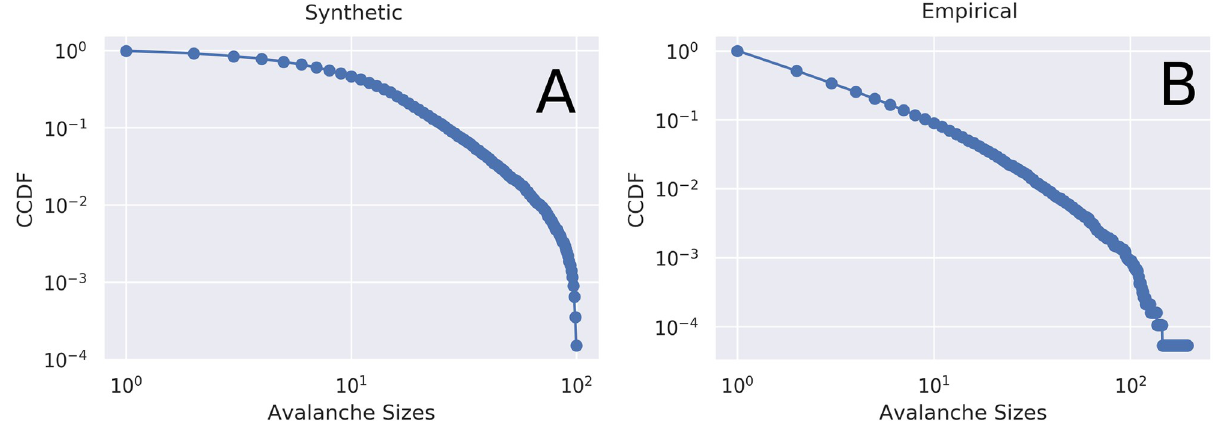
Fig 5. Synthetic and empirical doubly-truncated power law distributions for the data. A : an empirical, doubly-truncated power-law distribution taken from this dataset with an x min of 16 and an x max of 196. Within this range, the exponent has been estimated to be 2.7. B : a synthetic doubly- truncated power-law distribution with the same minimum and maximum values as the empirical distribution as well as the same exponent. Note that the synthetic model has significant curves which begin well before the upper-bound cut-off. When modelling a system that produces data within a fixed range, even power-law distributed values may not follow the canonical straight line when plotted in log-log space [51, 52].